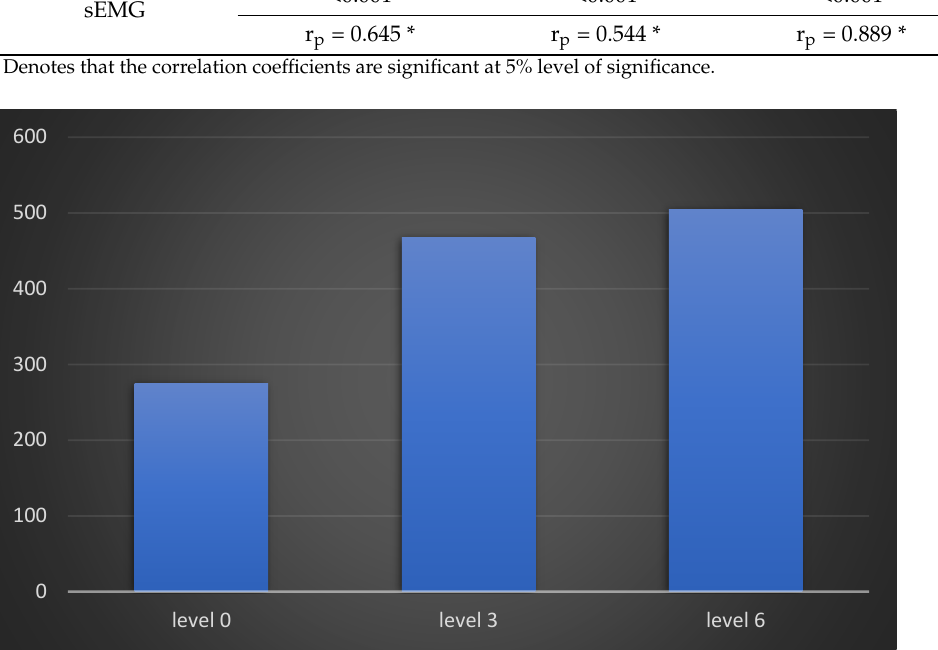
Figure 1. Maximum scores about responses for denture retention as perceived by patients at differ- ent levels.